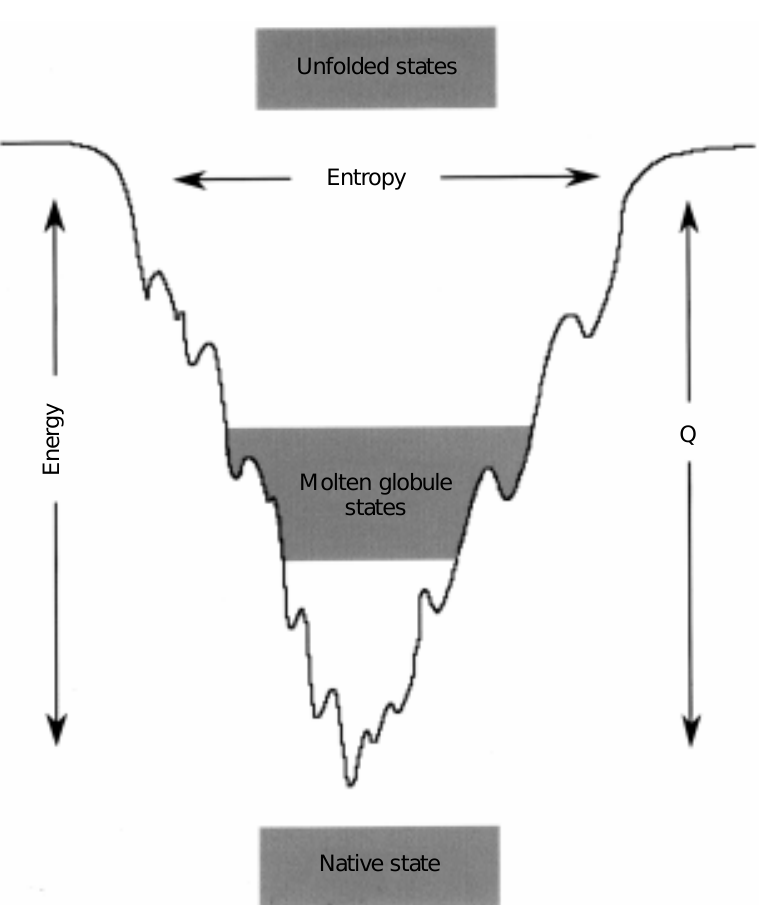
Figure 4 - A schematic two-dimensional representation of the folding funnel. The width of the funnel represents entropy, and depth the energy. Q is the fraction of native contacts indicated for each collection of states.